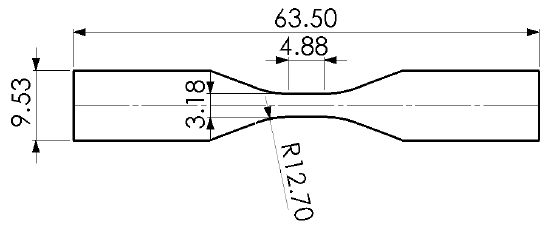
Figure 5. Dimensional profile (mm) of an ASTM D638-10 Type V tensile test specimen.